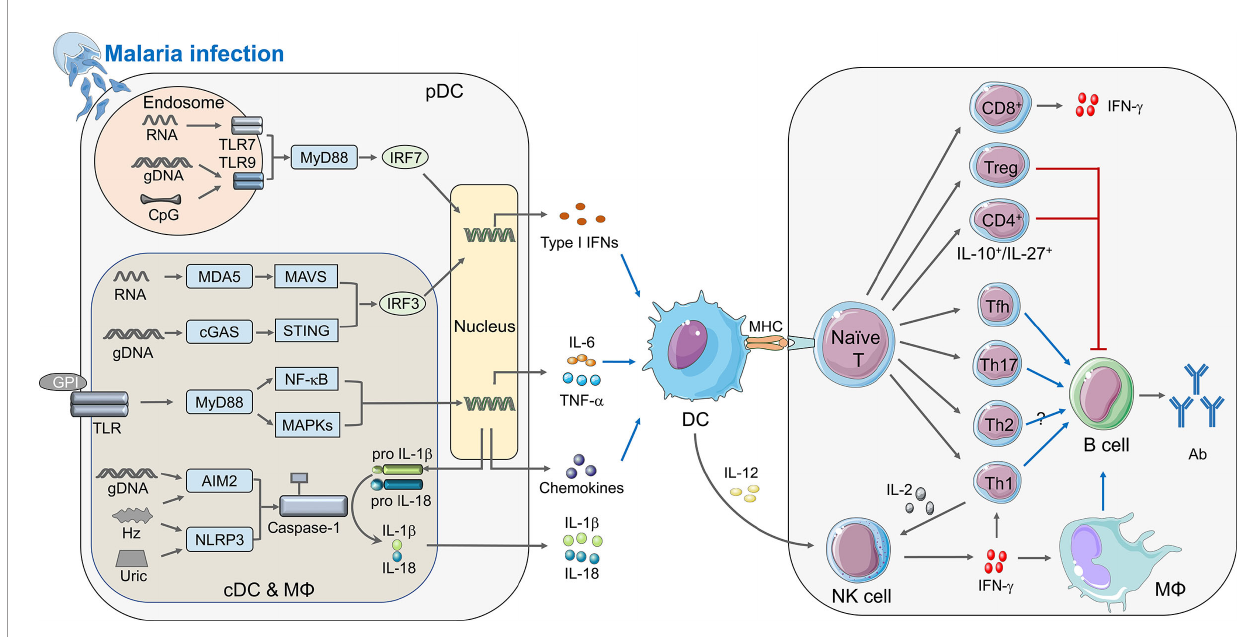
FIGURE 1 | Immune responses elicited by Plasmodium infection. During malaria infection, different PAMPs secreted from merozoites can be sensed by PRRs and activate the innate immunity (left panel). cDCs, macrophages, and pDCs are the crucial innate immune cells to defend malaria infection. Within the cytosol of these cells, pathogenic RNA interacts with MDA5 and recruits the adaptor protein MAVS, and Plasmodium gDNA can be detected by cGAS or other DNA sensors to activate adaptor protein STING. Both MAVS and STING could recruit serine/threonine-protein kinase TBK1 to phosphorylate IRF3 which translocate to nucleus and induce the expression of IFN-I. Furthermore, parasitic nucleic acid gDNA can also be sensed by in fl ammasome sensors AIM2, whereas haemozoin and uric acid activates NLRP3, leading to activation of in fl ammasomes and Caspase-1, which cleave pro-IL-1 b and pro-IL-18 to form mature IL-1 b and IL-18. Besides, parasite glycosylphosphatidylinositol (GPI) anchors to TLRs, including TLR2-TLR6 or TLR1-TLR2 heterodimers and TLR4 homodimers. TLRs signal transduces through MyD88, which fi nally causes the activation of NF- k B and MAPKs, and induces the secretion of pro-in fl ammatory cytokines, such as TNF- a and IL-6, as well as chemokines. Speci fi cally, both CpG and hemozoin-combined gDNA can induce TLR9 translocation, and TLR7 can sense parasite RNA in the endosome of pDCs during the early infection stage, TLR9 as well as TLR7 recruit adaptor protein MyD88 and kinases TRAFs to phosphorylate IRF7 and induce the early robust production of IFN-I. After the innate immune responses, DC acts as a vital APC receiving stimulation via cytokines described upon, is activated and presents the antigens to naïve T cell through combination of MHC and TCR, which builds a bridge between innate and adaptive immunity. During adaptive immunity (right panel), naïve T cells differentiate into different subtypes with unique functions in anti-malaria immunity. Tfh, Th1, and Th17 could facilitate function of B cells, while Treg and IL-10 + /IL-27 + CD4 + T cell can suppress B cell function; CD8 + T cells mainly express IFN- g , and leaving function of Th2 is still uncertain. Activated DCs can also secrete IL-12 to promote the expression of IFN- g from NK cell, which can enhance function of Th1 and macrophage thus help B cells to secrete antibody. Besides, IL-2 produced by Th1 can help NK cell to kill parasites. The diagram depicts a simpli fi ed version of indicated signaling pathway and immune cells involved in anti- malaria immunity. The abbreviations are de fi ned in